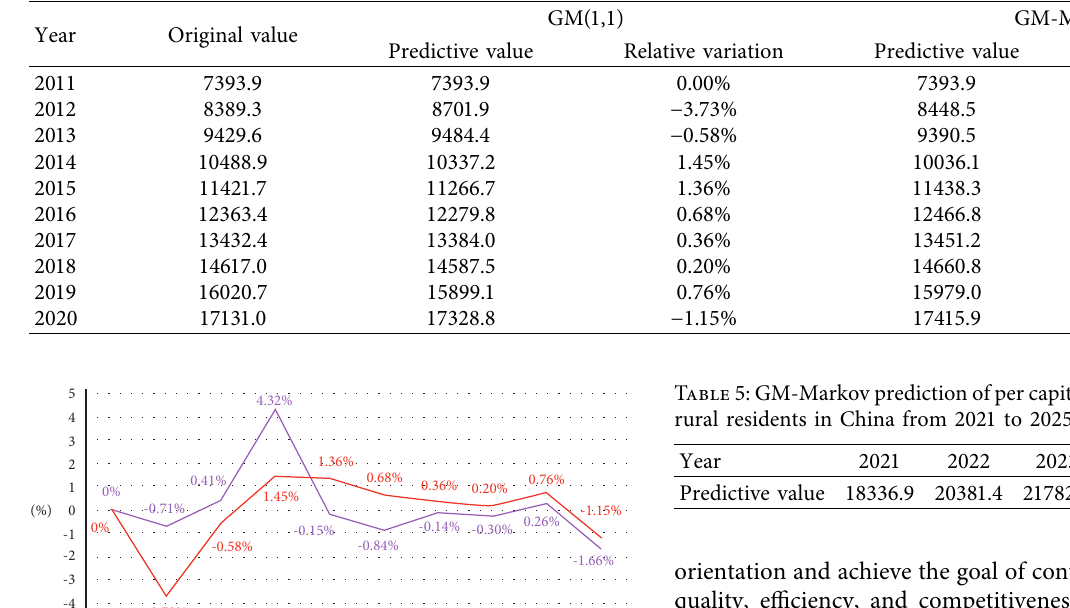
Table 4: Comparison of GM (1,1) and GM-Markov prediction results.